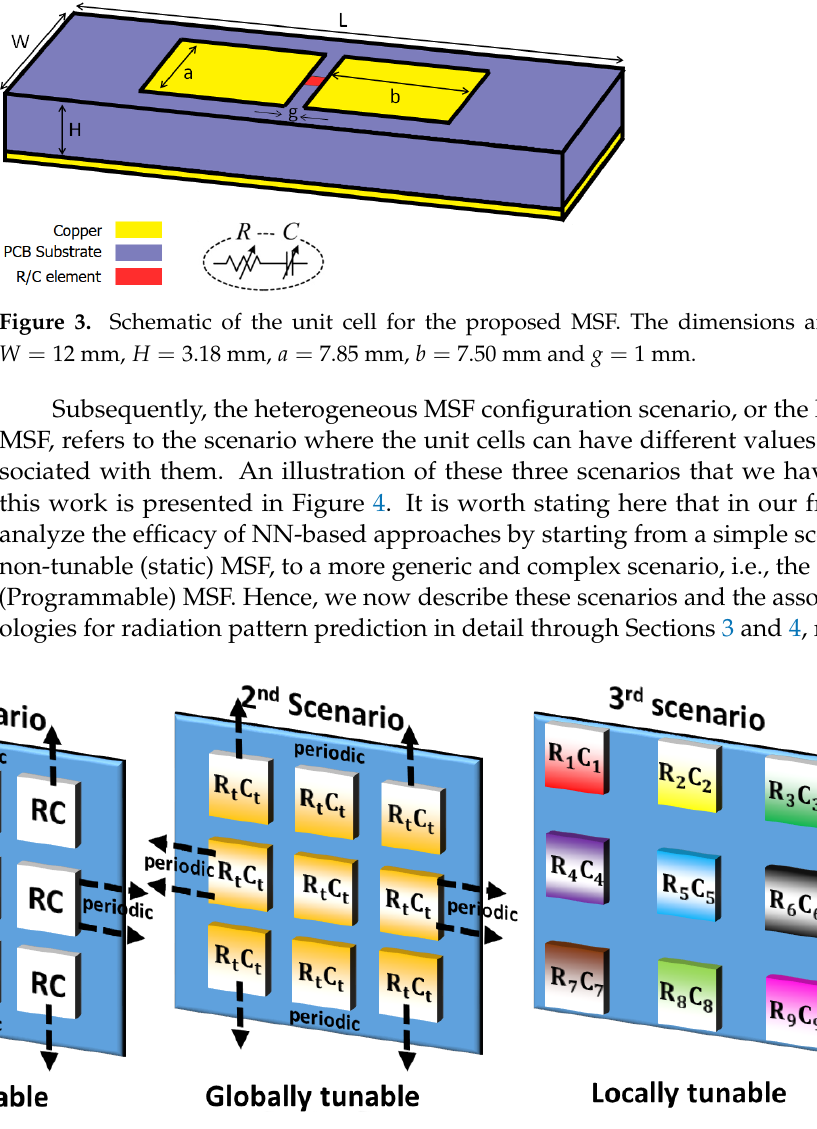
Figure 4. Diagram of the three scenarios utilized in the Incremental Design framework. Non-tunable and Globally tunable scenarios correspond to the broader homogeneous MSF configuration category, while the locally tunable scenario corresponds to the heterogeneous MSF configuration